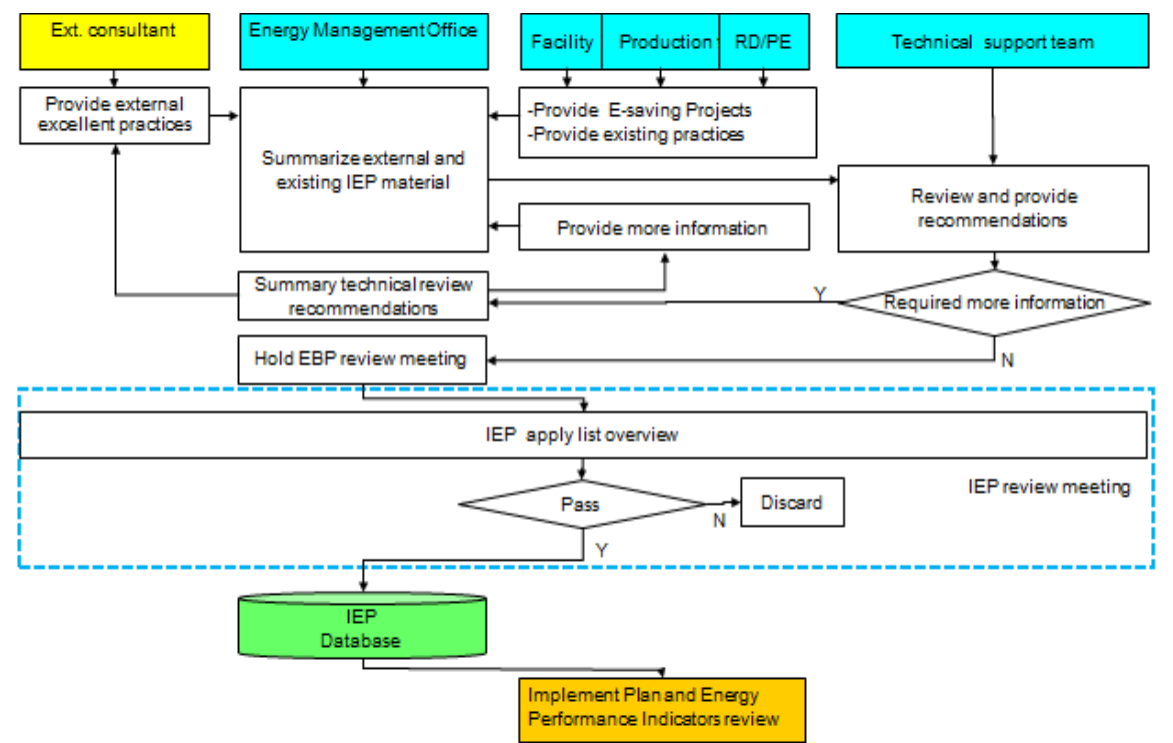
Figure 3. Integration-energy-practice (IEP) model review